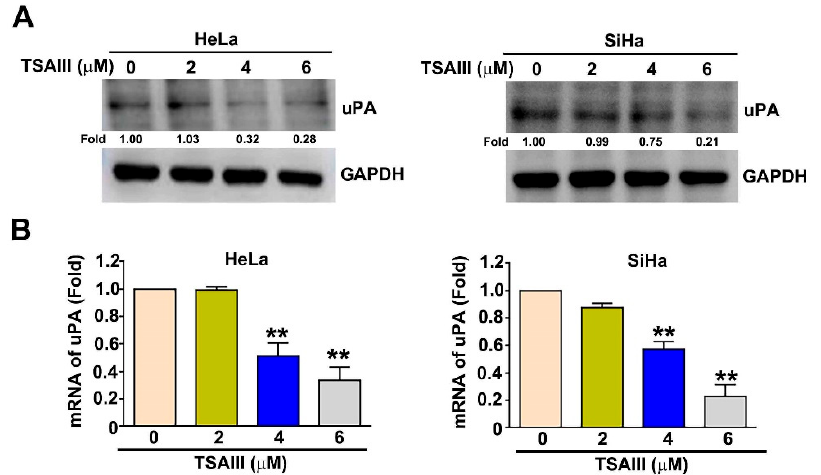
Figure 4. TSAIII regulation of uPA expression of human cervical cancer cells. Human HeLa and SiHa cervical cancer cells were treated with various concentrations of TSAIII (0, 2, 4 and 6 µM) for 24 h and then harvested to detect protein and mRNA levels of uPA through immunoblotting ( A ) and RT-qPCR ( B ) assays. GAPDH as internal control. ** p < 0.01 versus control (line 1) (mean ± SE, n = 3). Uncropped WB images were shown in Figure S1.